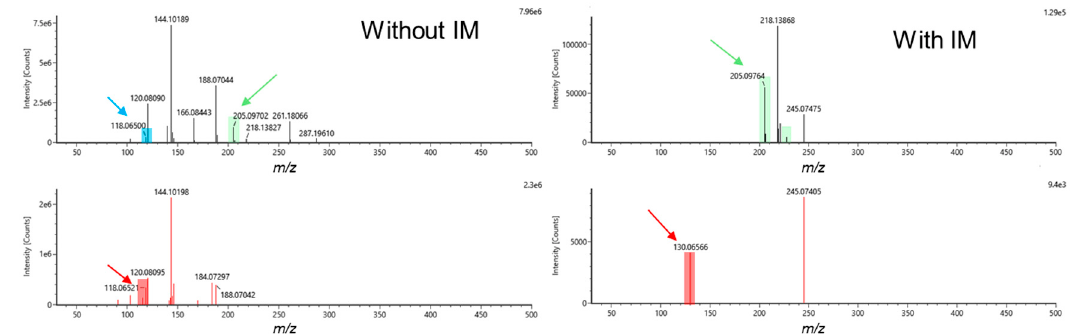
Figure 2. Example of MS and MS / MS spectra for tryptophan (M + H) + in hydrophilic interaction chromatography with amide (aHILIC) electrospray ionization (ESI) + for all ion fragmentation (AIF) ramp 10–60 eV with and without IM. The precursor ion m / z 205.0976 (green), in-source fragment m / z 118.0650 (blue), and fragment ions (red) m / z 118.0652 (AIF) and m / z 130.06566 (IM-AIF) were retrieved by the UNIFI software. In-source fragment at m / z 118.0650 is filtered out when the IM cell is